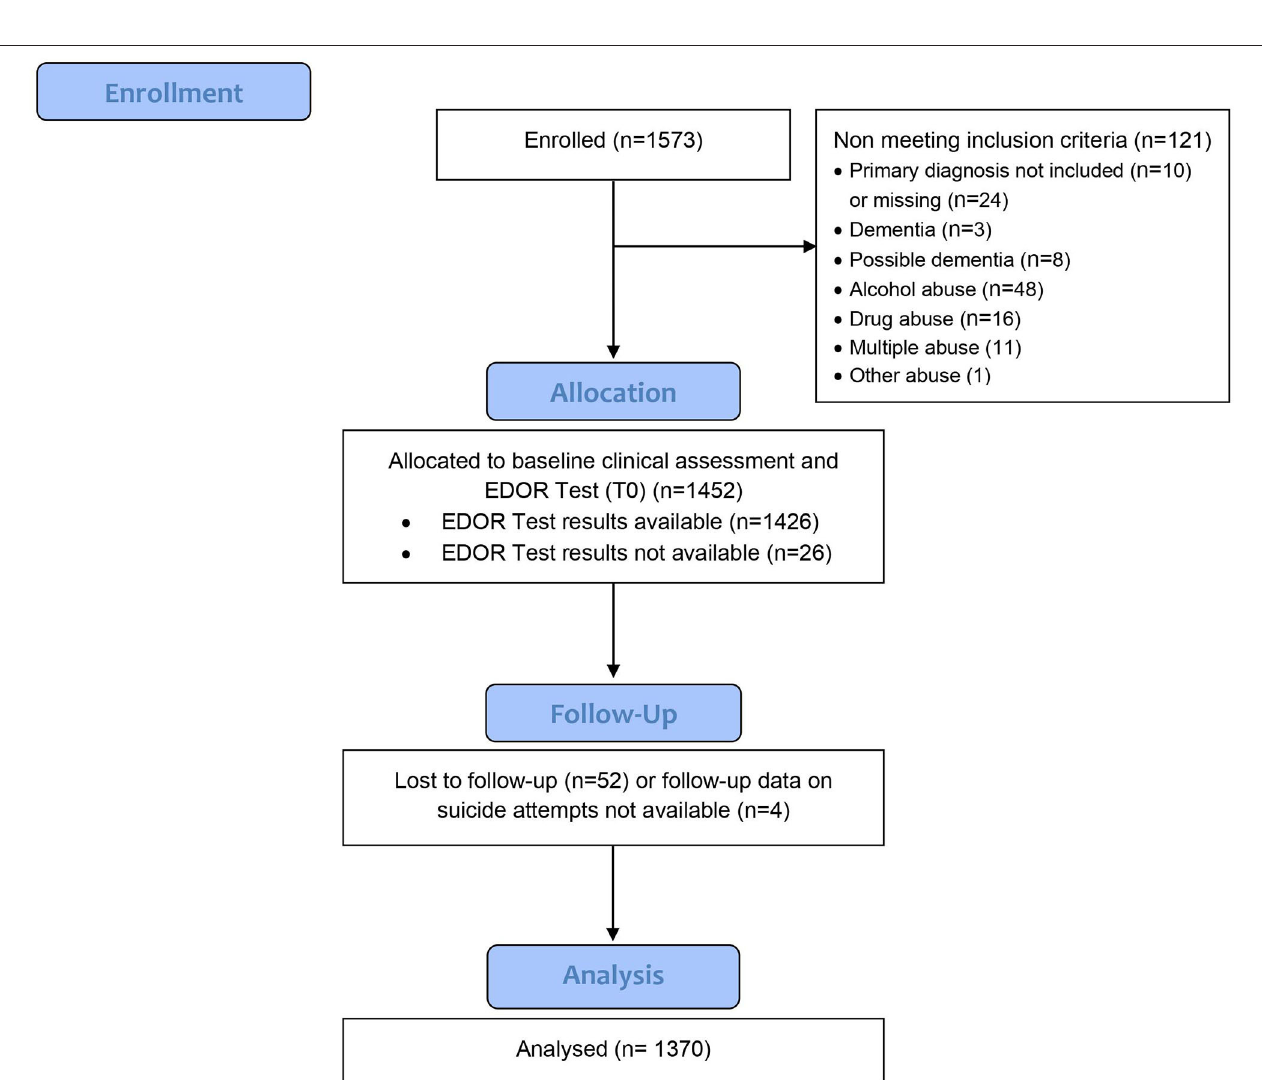
FIGURE 2 | CONSORT flow